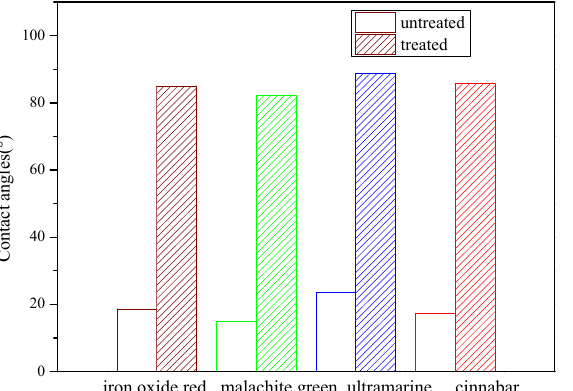
Figure 5. Contact angle of the treated and untreated samples for the four pigmented